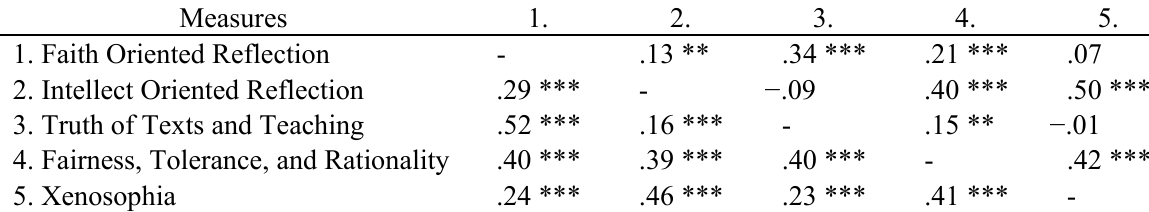
Table 4. Partial Correlations among Religious Reflection and Religious Schema Measures within Religious Fundamentalist (above the Diagonal) and Biblical Foundationalist (below the Diagonal) Ideological Surrounds